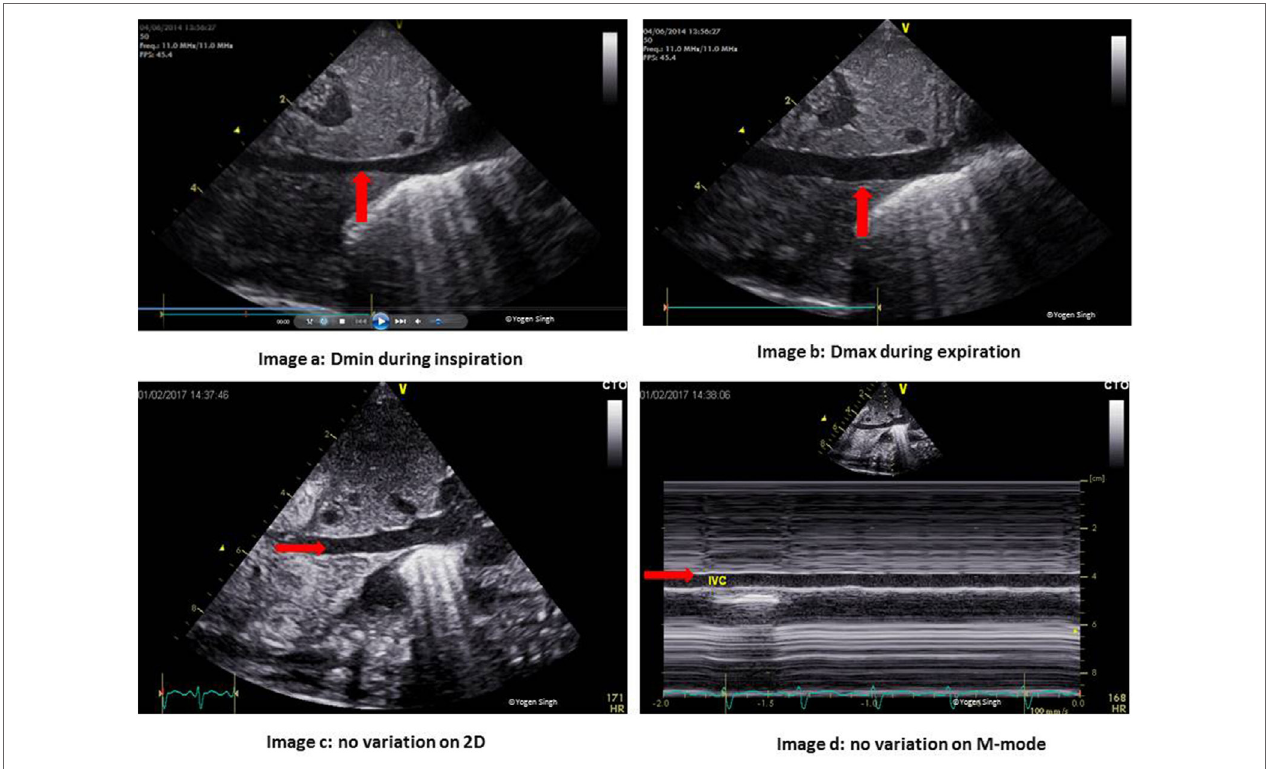
FiGURe 1 | Inferior vena cava (IVC) changes during the respiratory and cardiac cycles. Images a,b show normal physiological change in the IVC diameter during inspiration and expiration. Images c,d show no variation during the respiratory cycle in the presence of volume loading of the